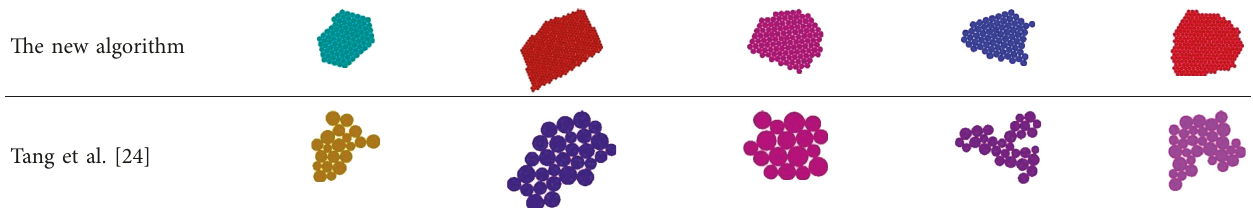
Figure 3: Comparison of granular particle size distribution of numerical model and actual sample. Table 1: Comparison of morphological features of particles generated with different algorithms.